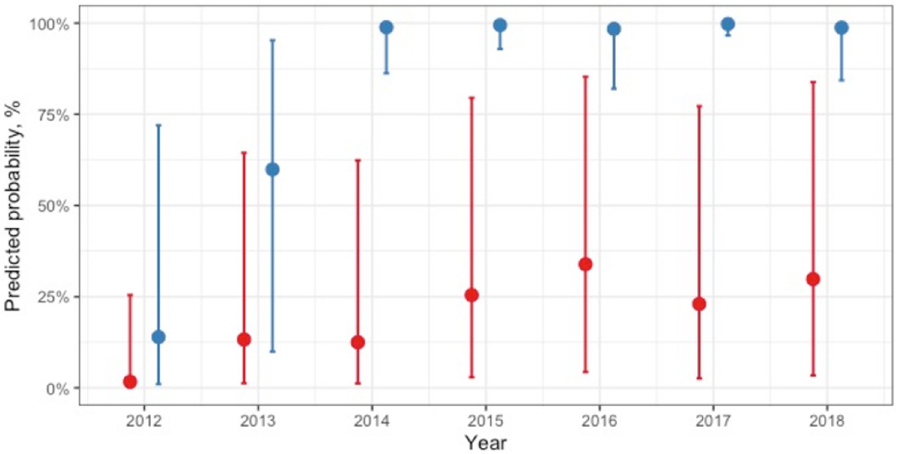
Fig 3. Predicted probabilities of brucellosis testing per month by year and facility ownership type. The red dots indicate point estimates with confidence intervals for government owned facilities. Blue dots indicate point estimates with confidence intervals for privately owned health